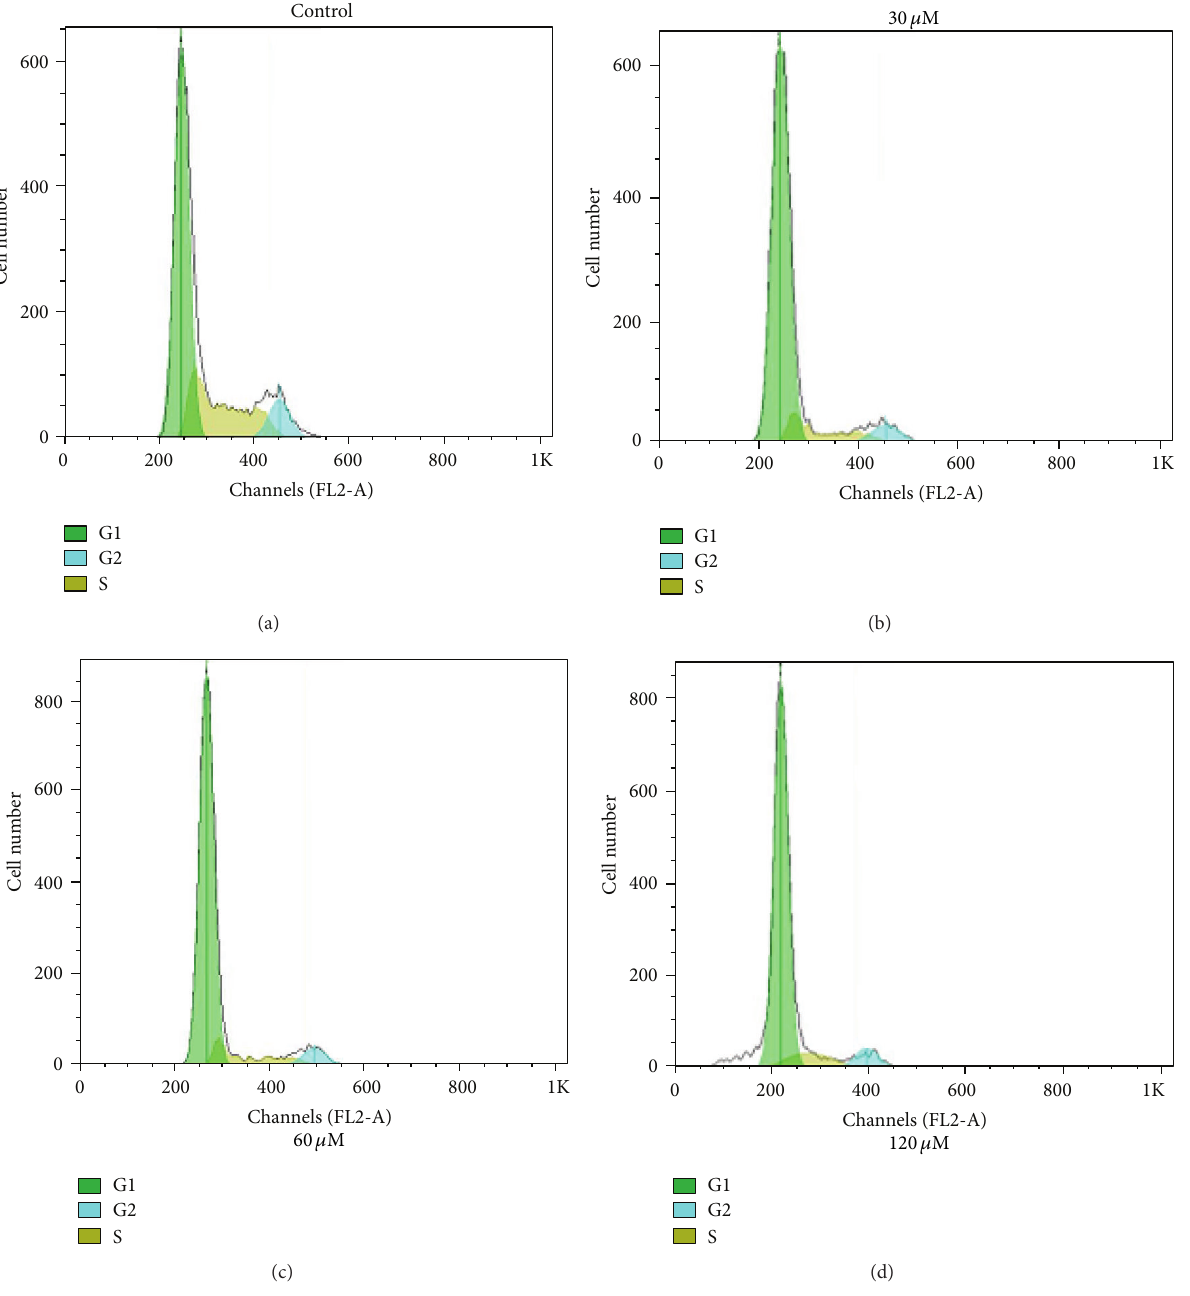
Figure 6: DNA content and cell cycle analysis of BEL-7402 cells after complex 2 treatment. BEL-7402 cells were cultured with either 0.1% DMSO (control), 30 𝜇 M, 60 𝜇 M, and 120 𝜇 M of complex 2 for 48h. The percentage of nonapoptotic cells within each cell cycle was determined by flow